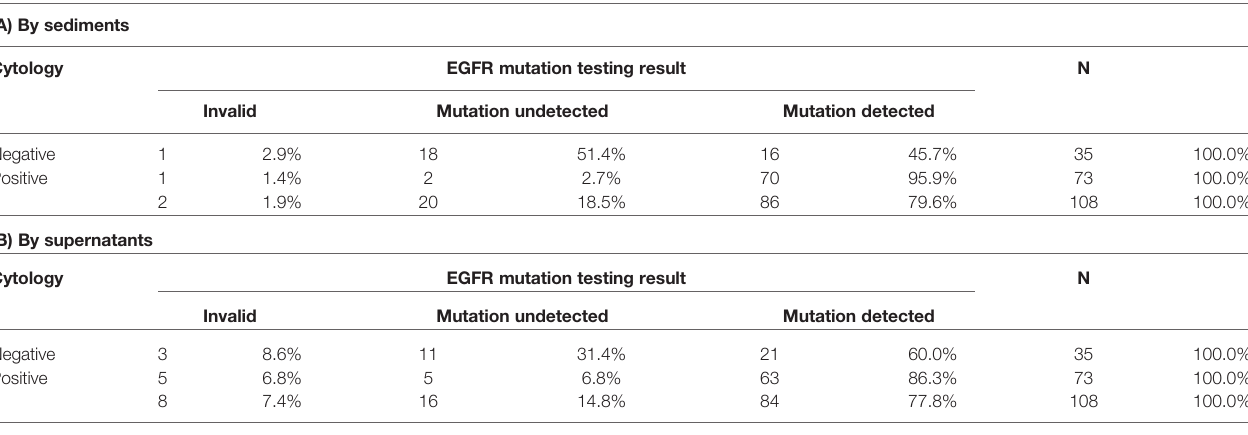
TABLE 3 | Effusion cytology and EGFR mutation